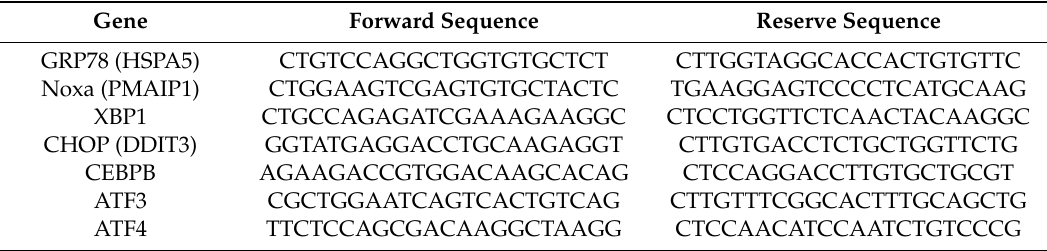
Table 1. Primers for real time